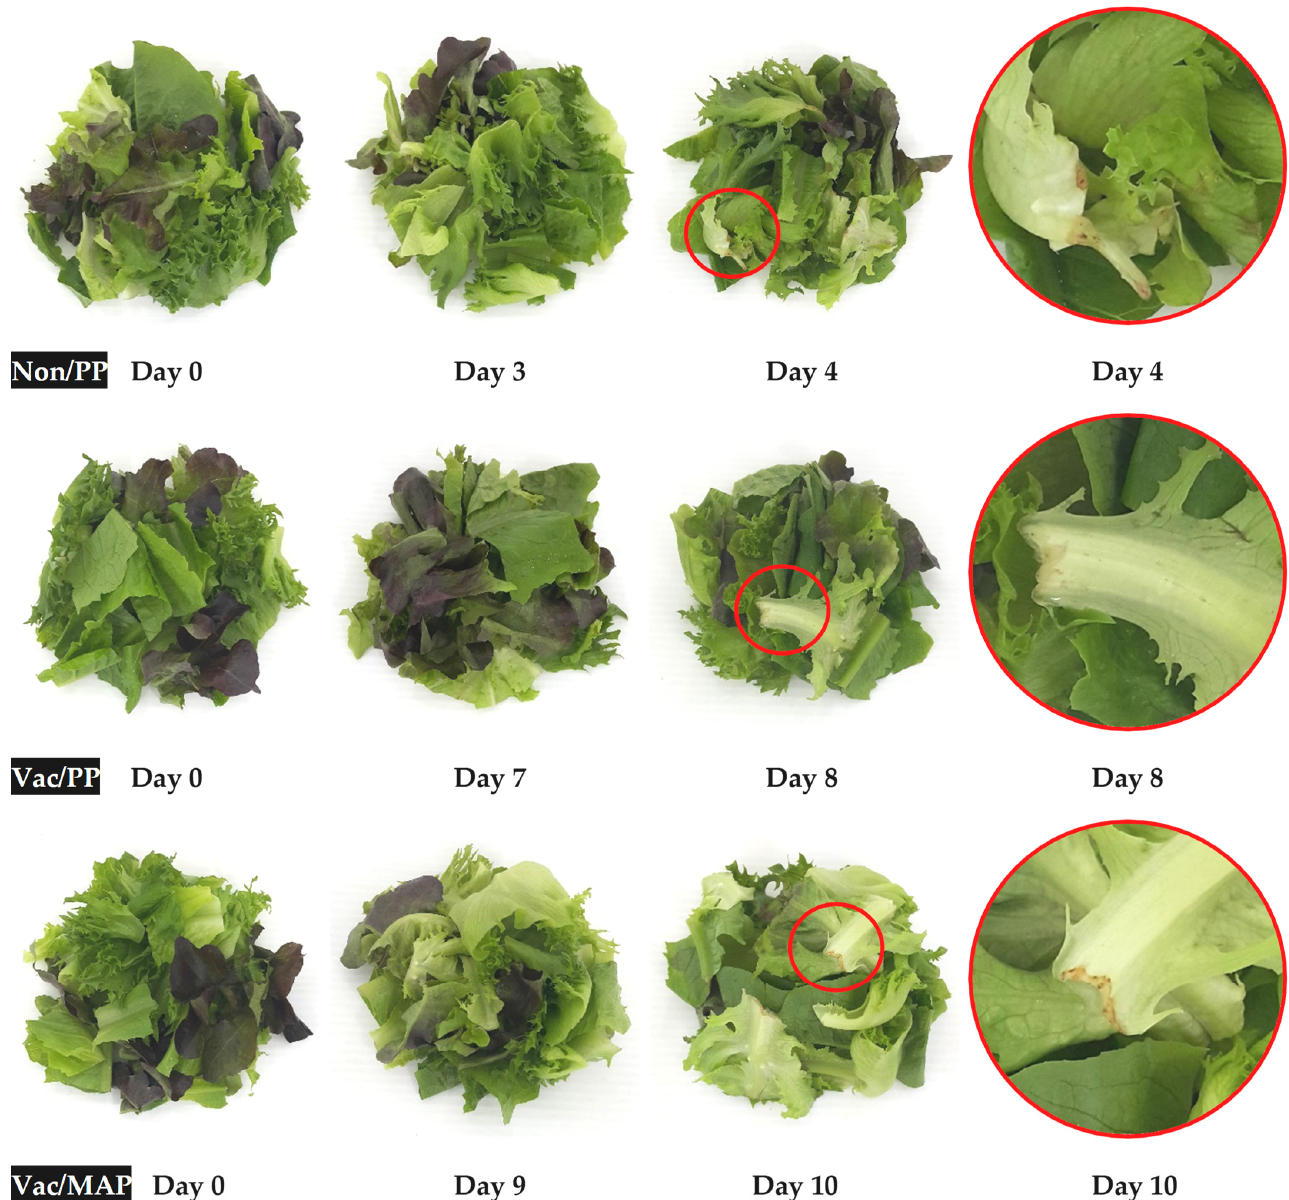
Figure 3. Images of fresh-cut vegetables during storage at 4 ◦ C at various storage time; Non/PP at day 0, 3, 4 ( first row ), Vac/PP at day 0, 7, 8 ( second row ), and Vac/MAP at day 0, 9, and 10 ( third row).